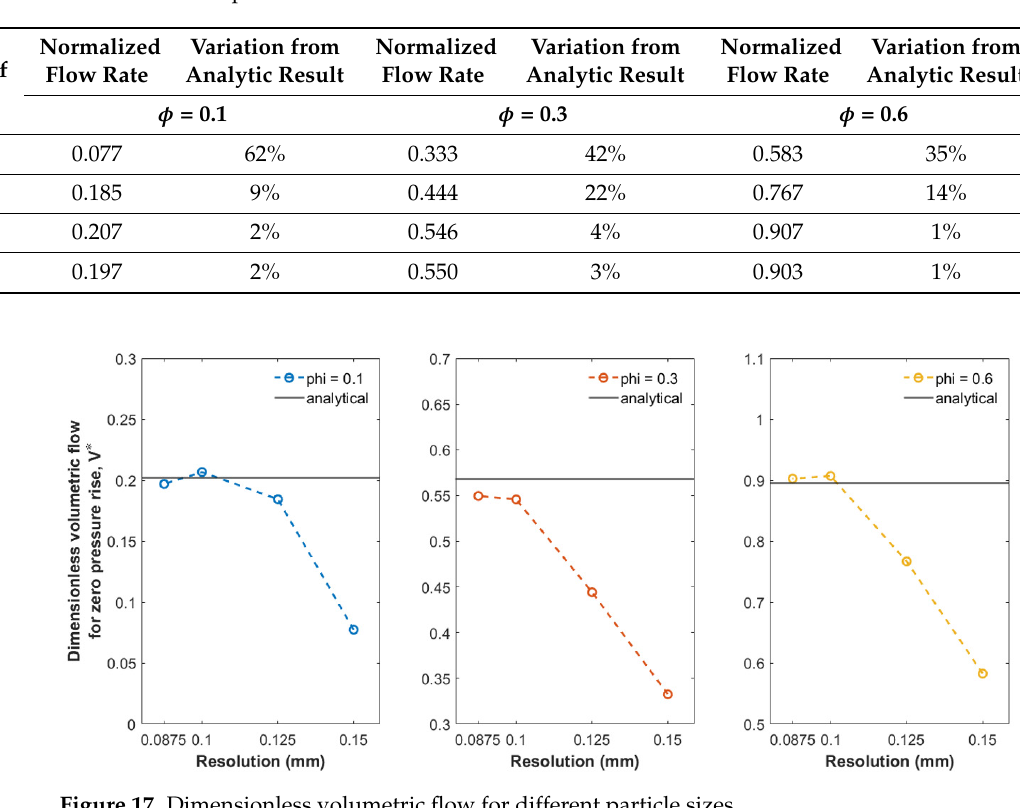
Figure 17. Dimensionless volumetric flow for different particle sizes.